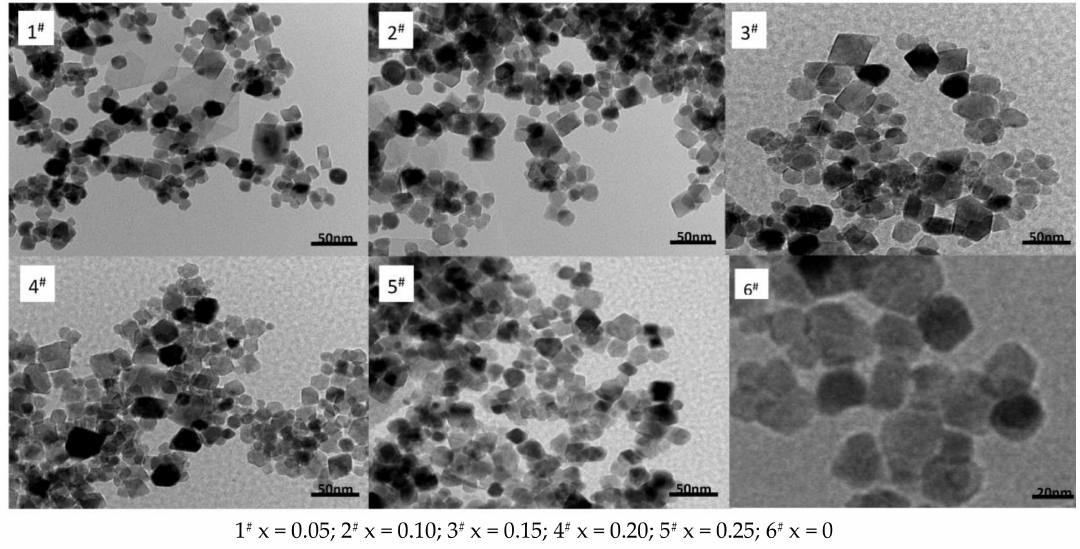
Figure 6. Transmission electron micrograph of samples prepared with different Mn 2+ content.